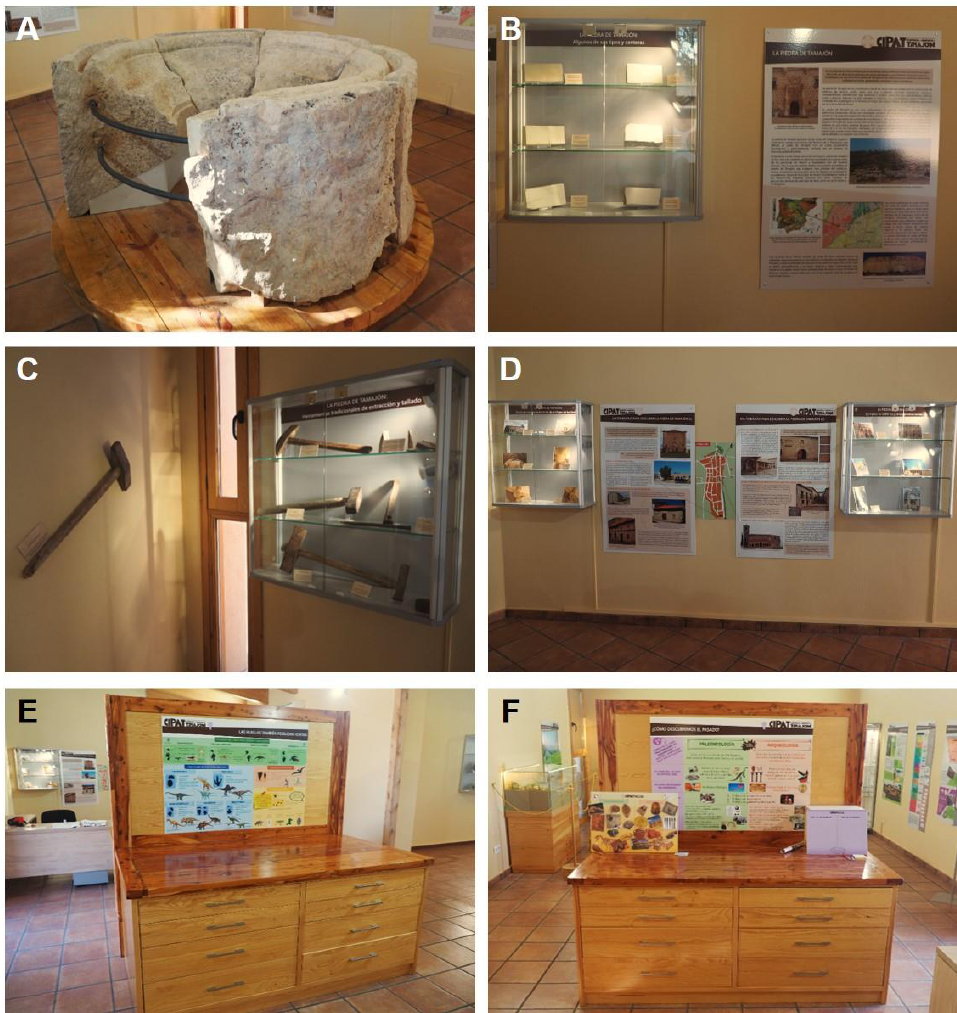
Figure 6. ( A ) Image of the frame of the 16th century rose window from the hermitage “Ermita de los Enebrales” of Tamajón (Guadalajara, Spain), carved in Tamajón Stone, as central outstanding piece of the Archaeological Area of the Paleontological and Archaeological Interpretation Centre of the locality (CIPAT); ( B ) Photograph of the display case of the same area with lithotypes from different historical quarries of Tamajón Stone and, on the right, the panel “La Piedra de Tamajón -The Tamajó n Stone” ; ( C ) Image of the display case of the same area with traditional stonemason tools historically used in the extraction and carving of natural stone; ( D ) Photograph of the display cases of the same area with images of buildings and details, both ancient and modern, constructed with Tamajón Stone , separated by the two panels “Un itinerario para descubrir la Piedra de Tamajón -An itinerary to discover the Tamajón Stone ” and a map, with a proposal for an educational itinerary in the town to discover and interpret some of the buildings constructed with this valuable raw material; ( E , F ) Images of the table with drawers and a central panel to carry out the activities of the Didactic Area of the CIPAT, showing the panels “Las huellas también fosilizan: Icnitas-Tracks also fossilise: Ichnites” ( E ); and “¿Cómo descubrimos el pasado?: Paleontología vs. Arqueología-How do we discover the past: Paleontology vs. Archaeology?” and other educational resources ( F ).